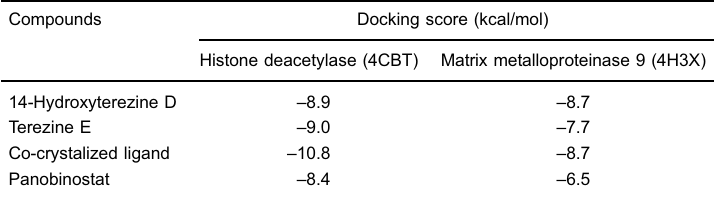
with PHE:871 by pi-pi stacked bond. The co-crystalized ligand and compound 1 interacted with His:842 in the active site of the protein with two different types of